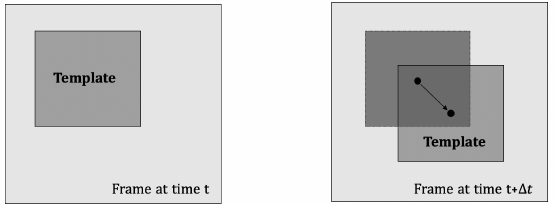
Figure 2. Template shifts between two successive